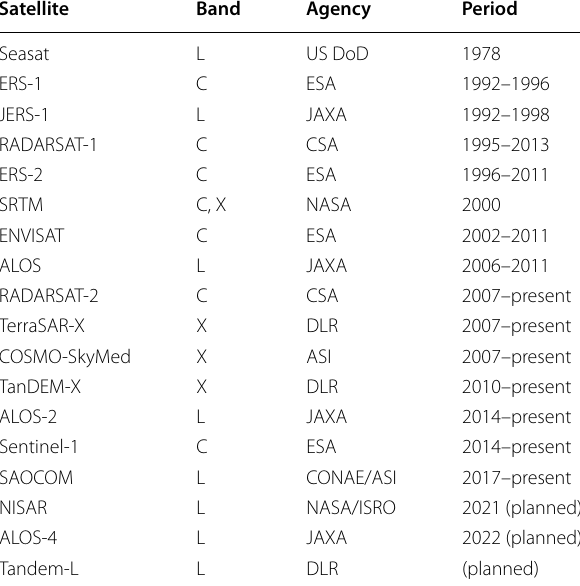
Table 1 List of SAR